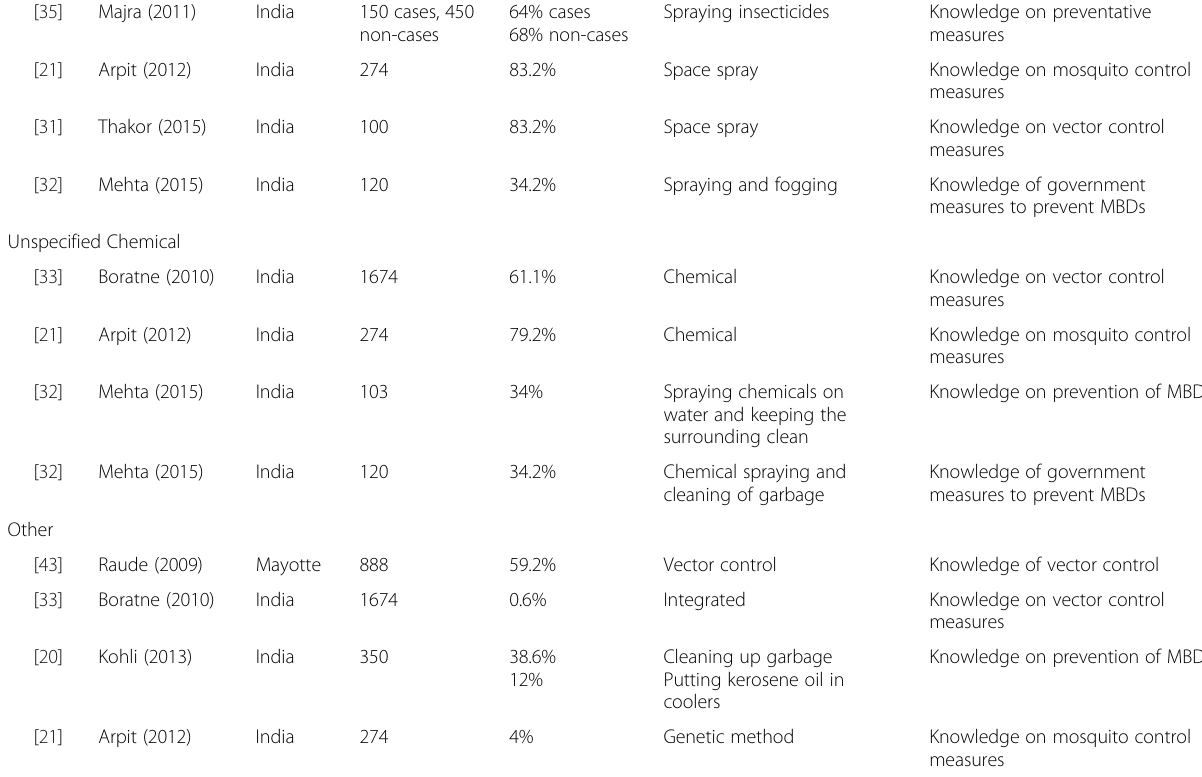
Table 4 Knowledge of the general public on vector control